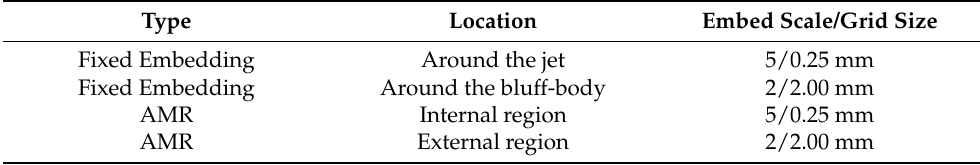
Table 2. Grid control details for the nonreactive flow